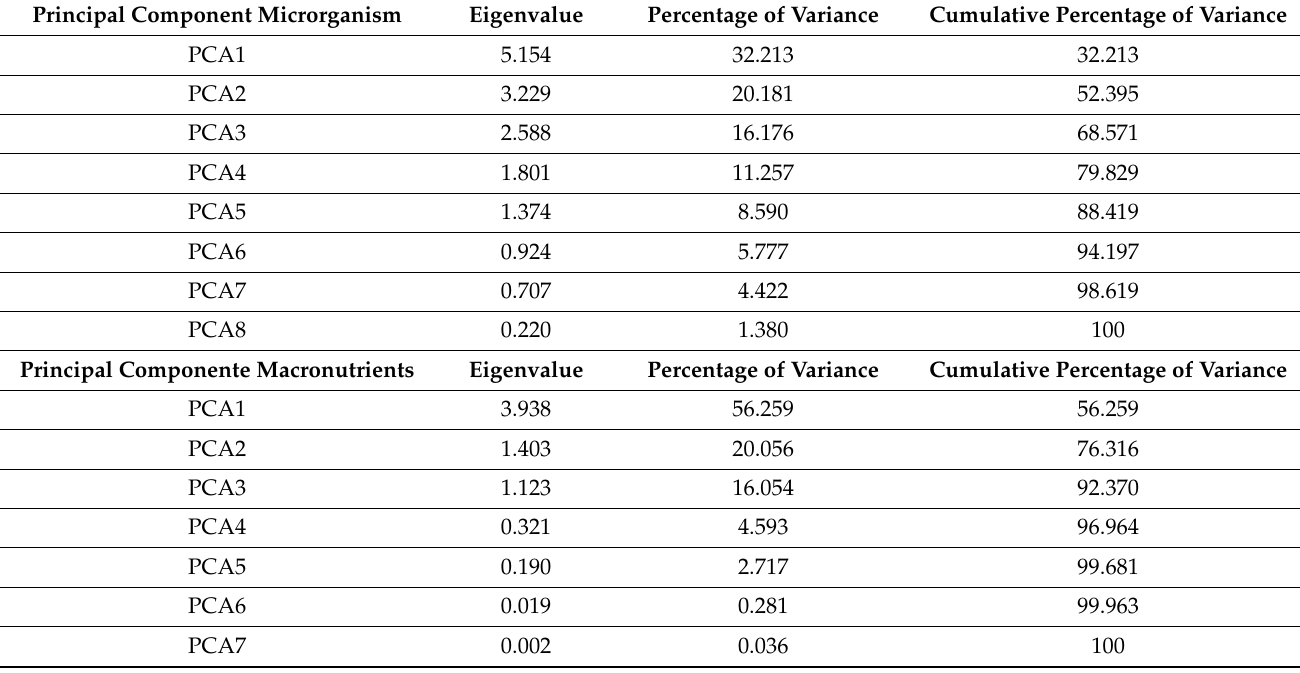
Table 7. Principal components, eigenvalues, and percentage of variance are explained by